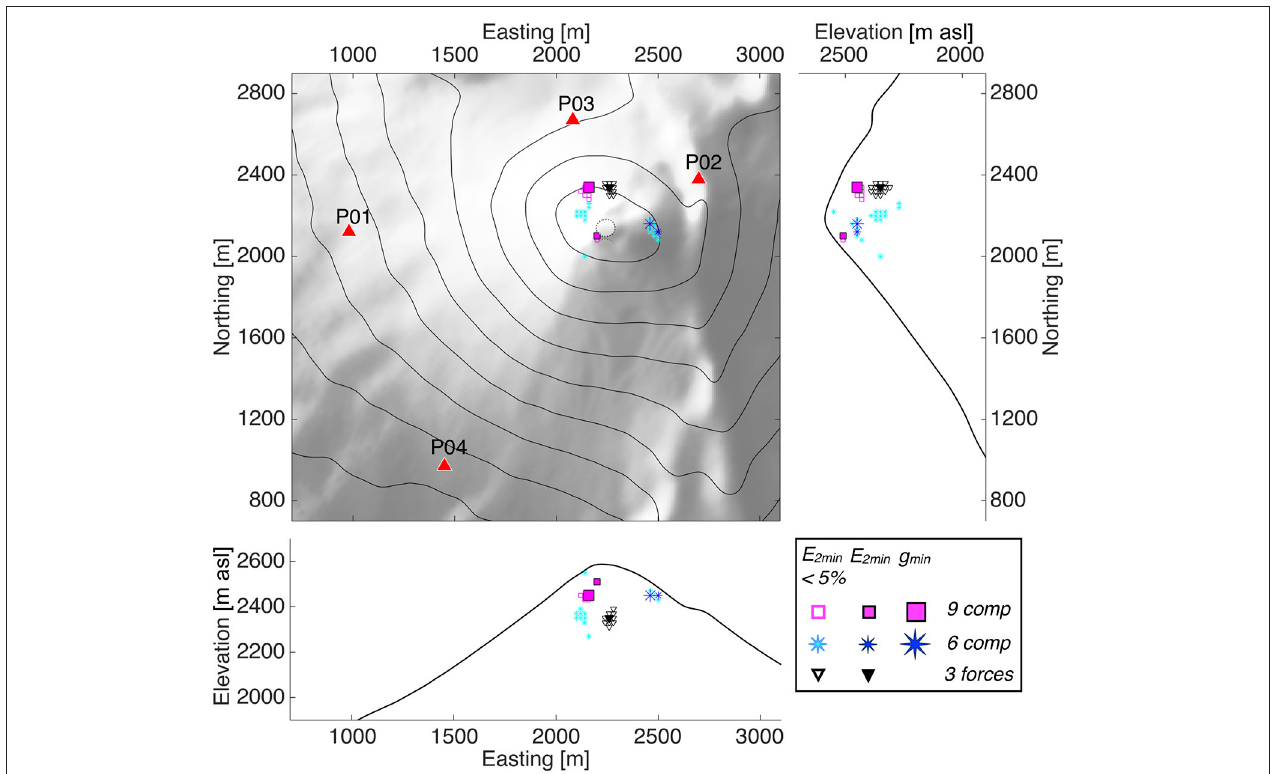
FIGURE 6 | Locations of best-fit source centroids for minimum misfit ( E 2 min ), for all solutions within 5% of the minimum misfit ( E 2 min < 5 %), and when both source-time function stability and minimum misfit are considered ( g min ). Locations for all three unconstrained inversion trials are shown. Contour interval is 100m. Red triangles indicate the broadband network